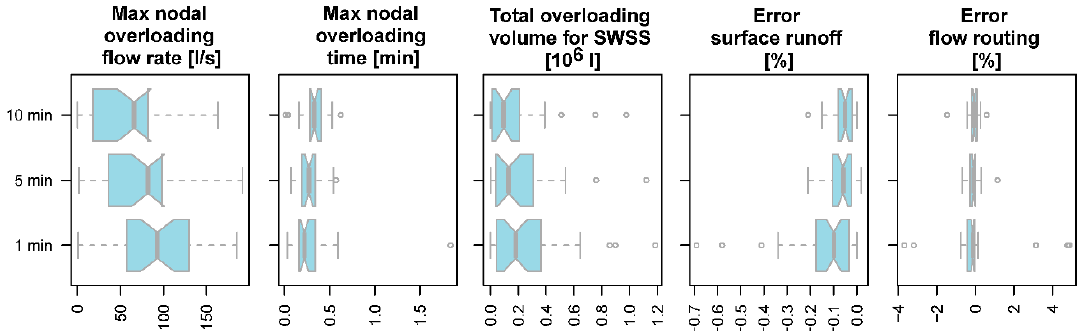
Figure 9. Box-plots of SWSS overloading parameters and simulation errors with different precipitation data resolution.